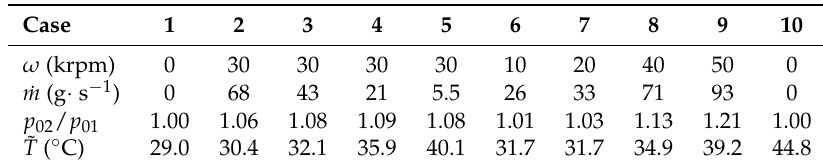
Table 1. Tested cases showing rotational speed ω , mass flow ˙ m , stagnation pressure ratio p 02 / p 01 over the compressor, and median blade temperature ˜ T